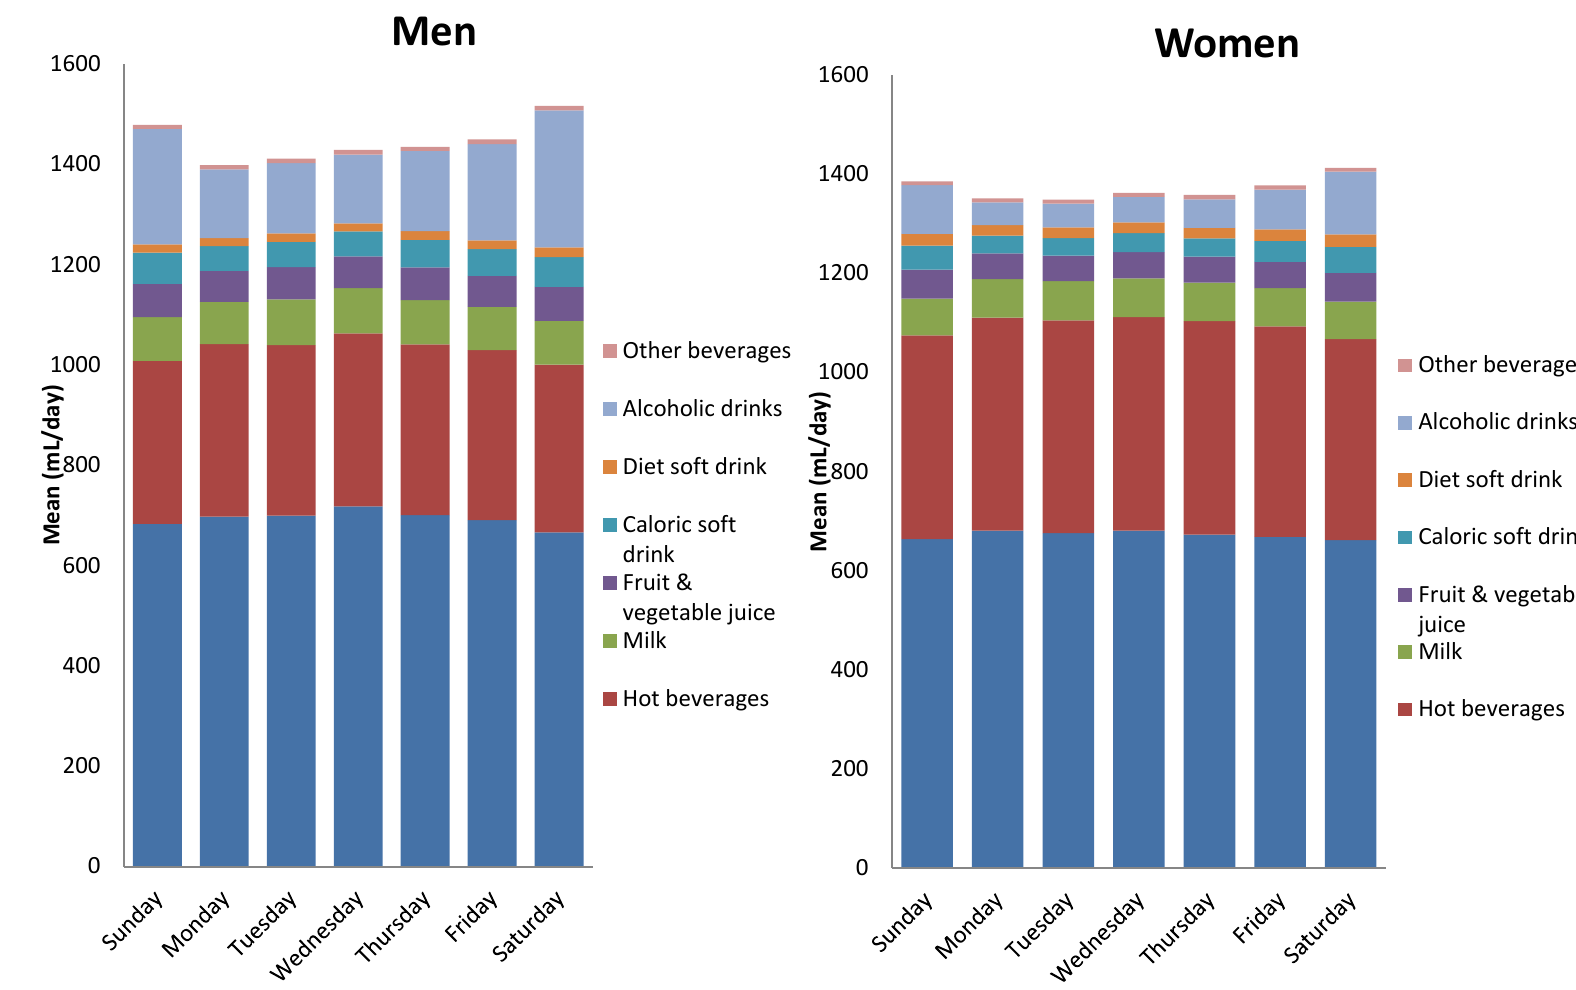
Figure 3. Amount and types of beverages consumed according to day of the week (mean mL/day), separated by gender.